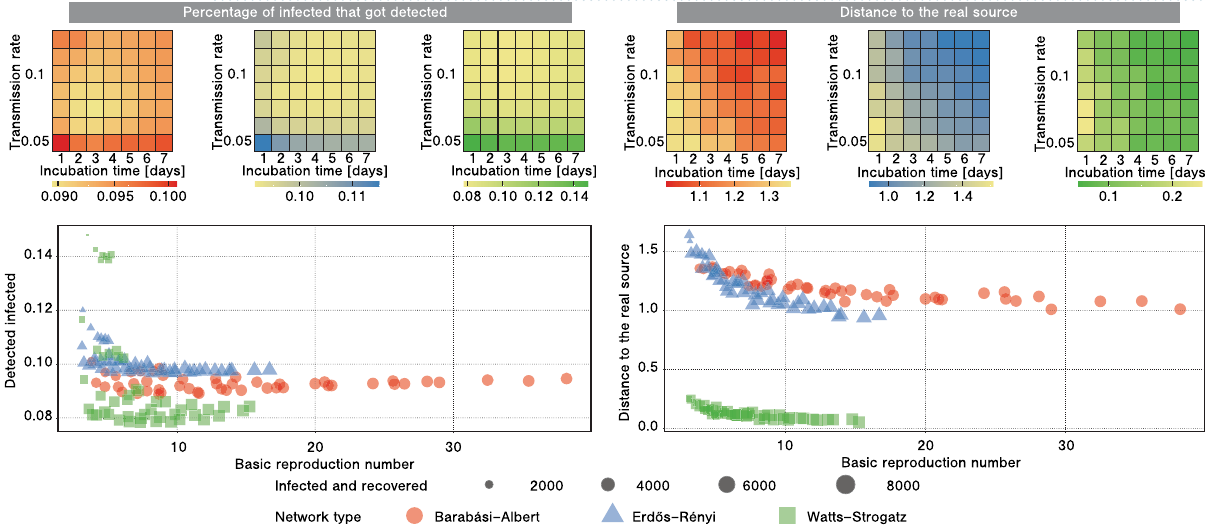
Figure 5. The effectiveness of tracing when changing infection characteristics. In each heatmap, the x-axis corresponds to the presymptomatic period µ p of the infection expressed in days, while the y-axis corresponds to the transmission rate α expressed as a probability. In each scatter plot, the x-axis corresponds to the basic reproduction number computed after a week of the infection, while the y-axis corresponds to either the percentage of infected nodes that got detected or the distance to the real source. Each point in a given plot corresponds to a different parameterization of the diffusion process (same as in the heatmaps), with the size of each point corresponding to the number of people that ever got infected. The results are presented for networks with 10,000 nodes generated using different models, either Barabási–Albert, Erdős–Rényi, or Watts–Strogatz, with tracing budget b = 100 , tracing breadth β tr = 10 . The results are presented as an average of over 1000 simulations, with a new network generated for every